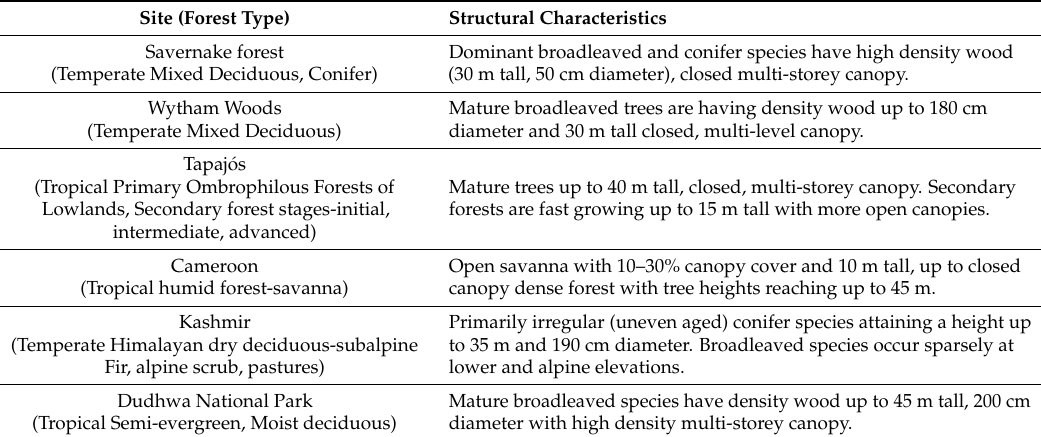
Table 1. Summary of test sites with forest structural